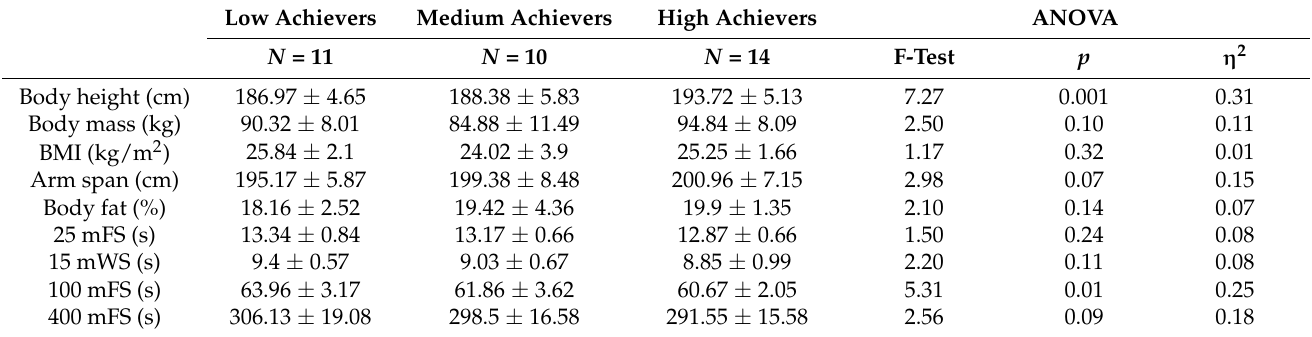
Table 2. Descriptive statistics and differences derived by analysis of variance (ANOVA) among qualitative groups for center players (results are presented as means ± standard deviations).